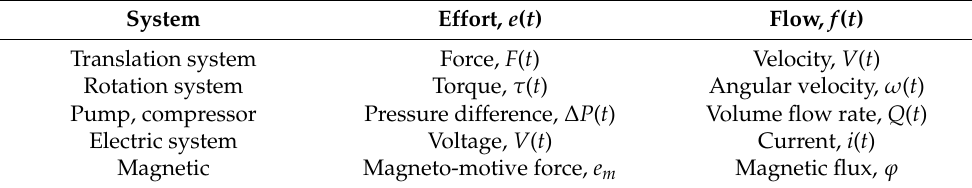
Table 2. Power concept in a multi-port product expressed as effort and flow. System